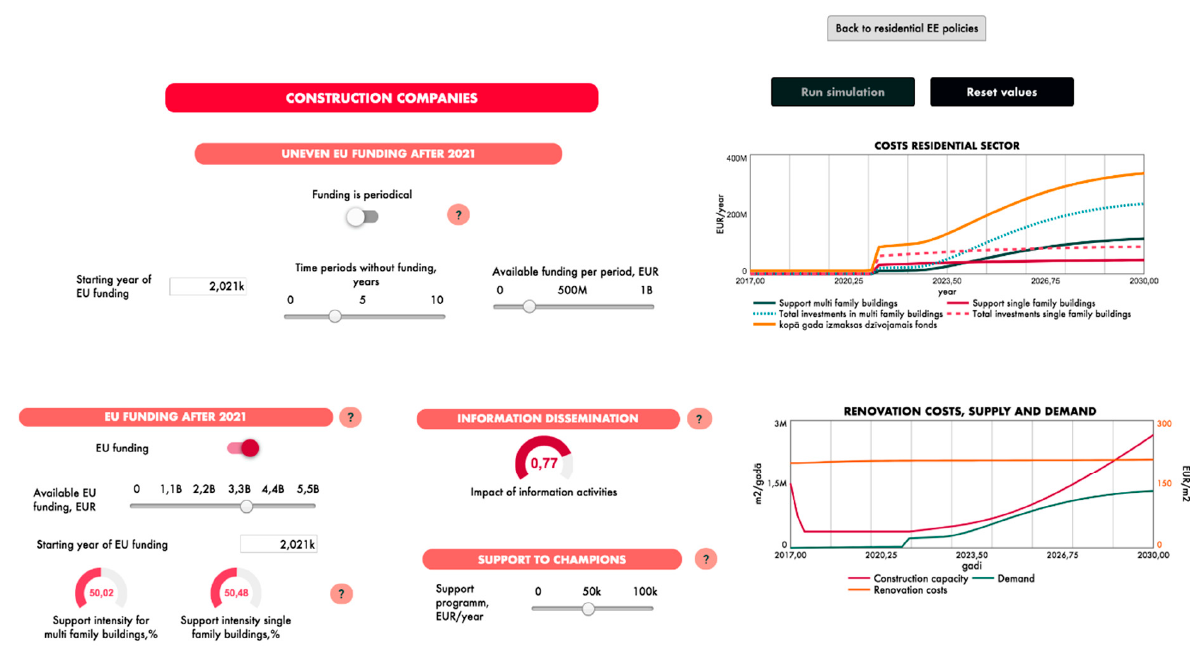
Figure 12. Interface for more in-depth policy analysis of supply and demand of construction companies.